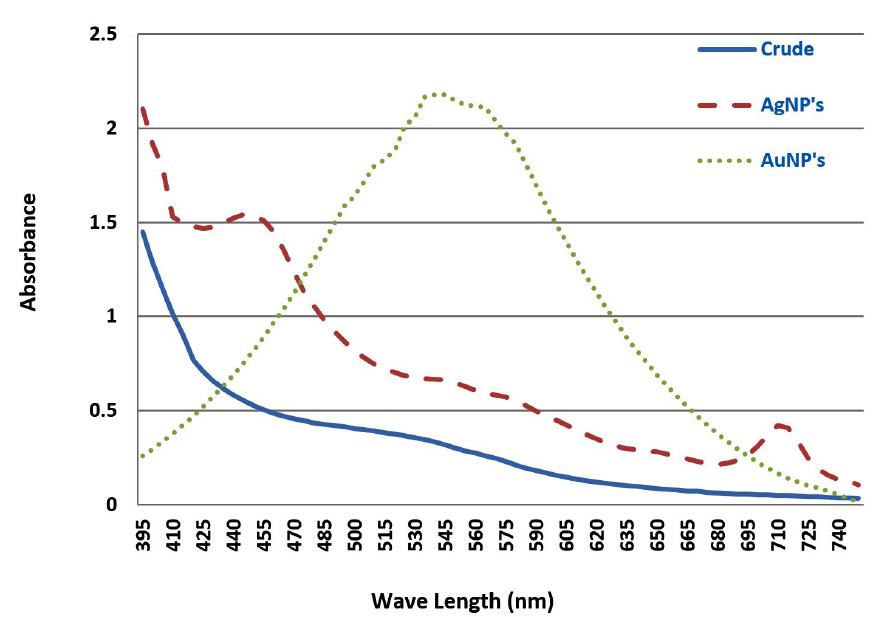
Fig. 1. UV-Visible analysis of D. salicifolia crude extract, gold nanoparticles (AuNPs) and silver nanoparticles